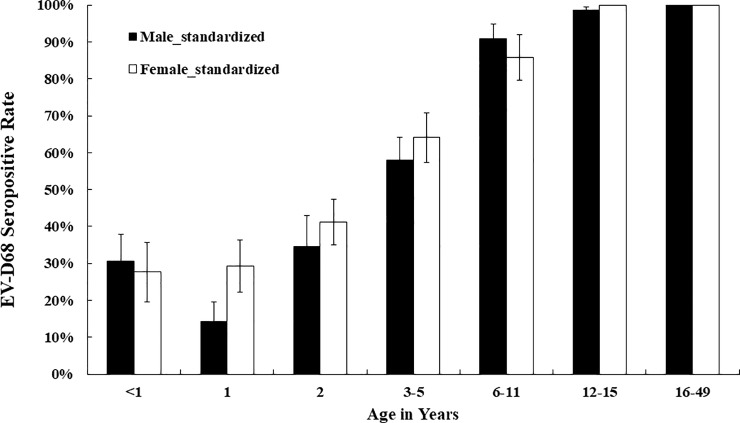
Age-specific EV-D68 serostatus between males and females in 2017.The bars demonstrate the mean seropositive rate ± standard error.